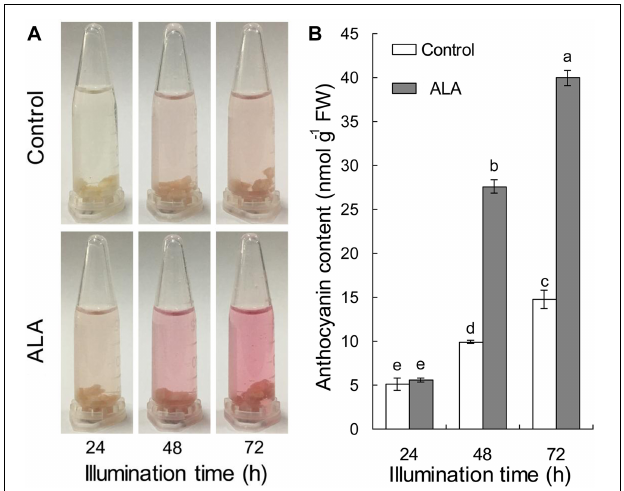
FIGURE 1 | Time courses of anthocyanin accumulation after ALA treatment in fruit calli. The calli were incubated with 50 mg L − 1 ALA or deionized water (Control) for 3 h under dark and then cultured in solid MS medium under light of 100 µ mol m − 2 s − 1 photon flux density at 22 ◦ C for 72 h. (A) The process of color development in calli under light. (B) Anthocyanin content in calli. The different small letters represent significant differences ( p < 0.05).